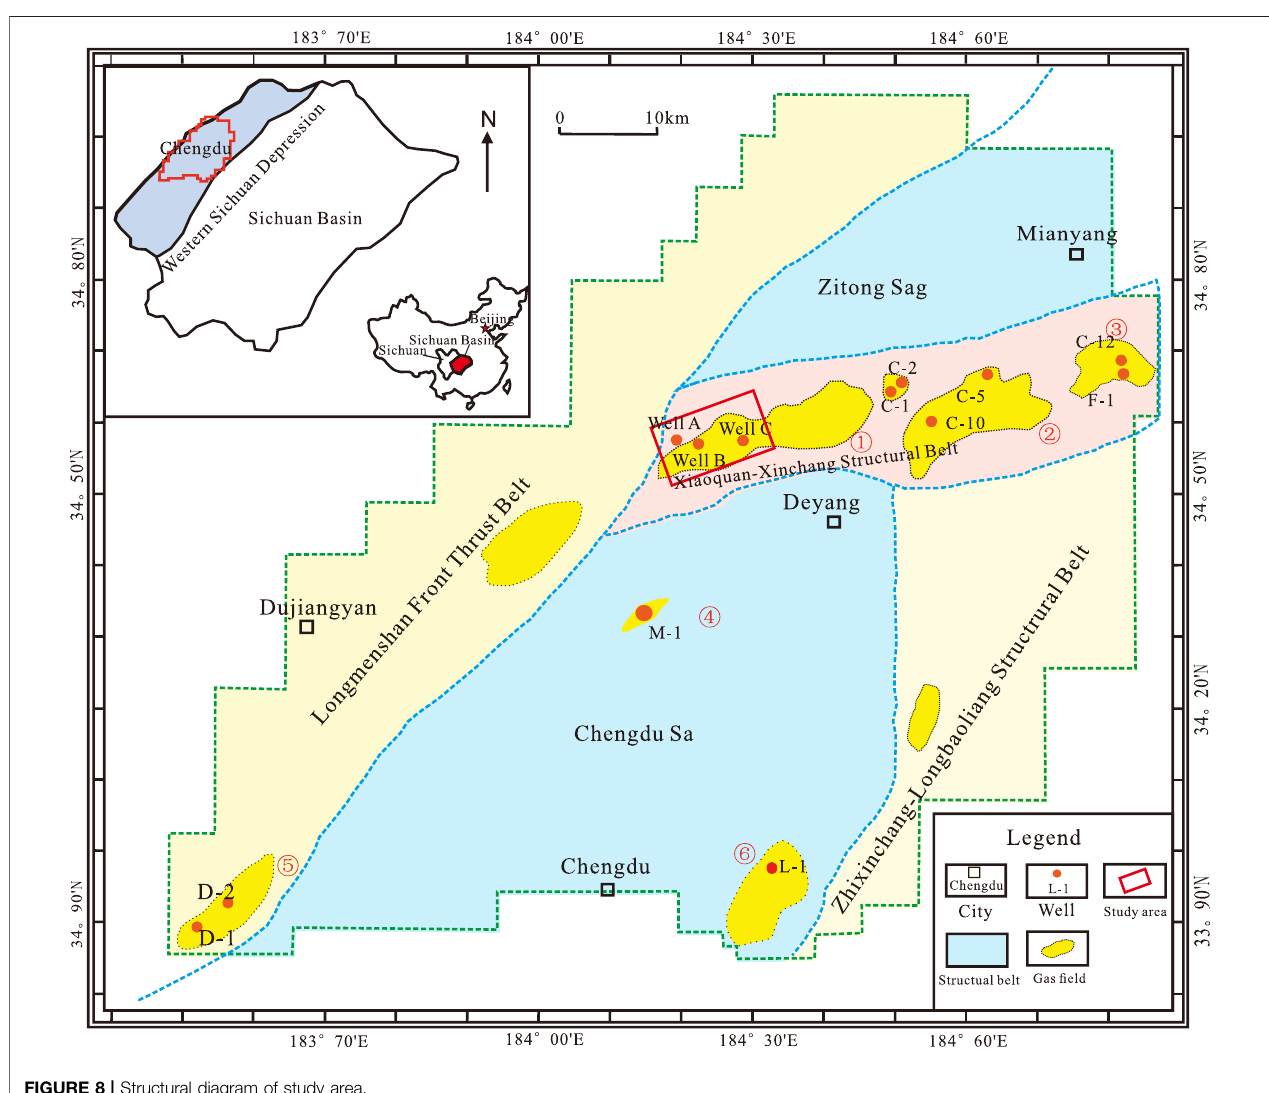
FIGURE 8 | Structural diagram of study